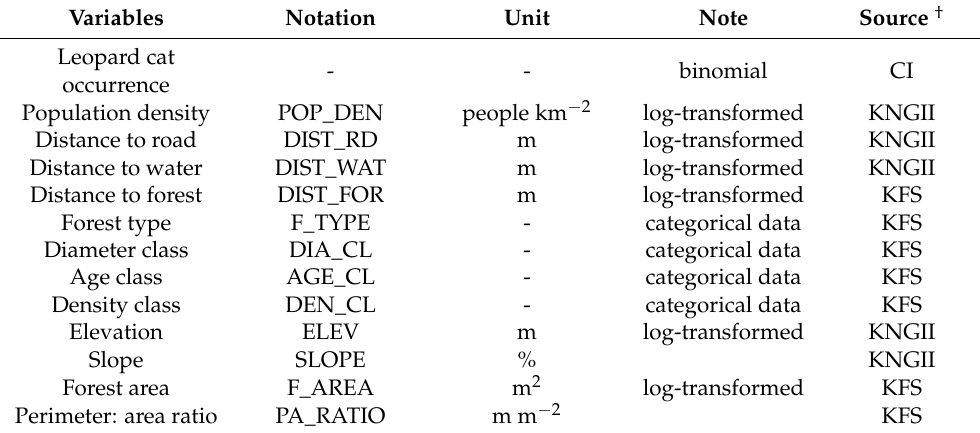
Table 1. Description of variables for model